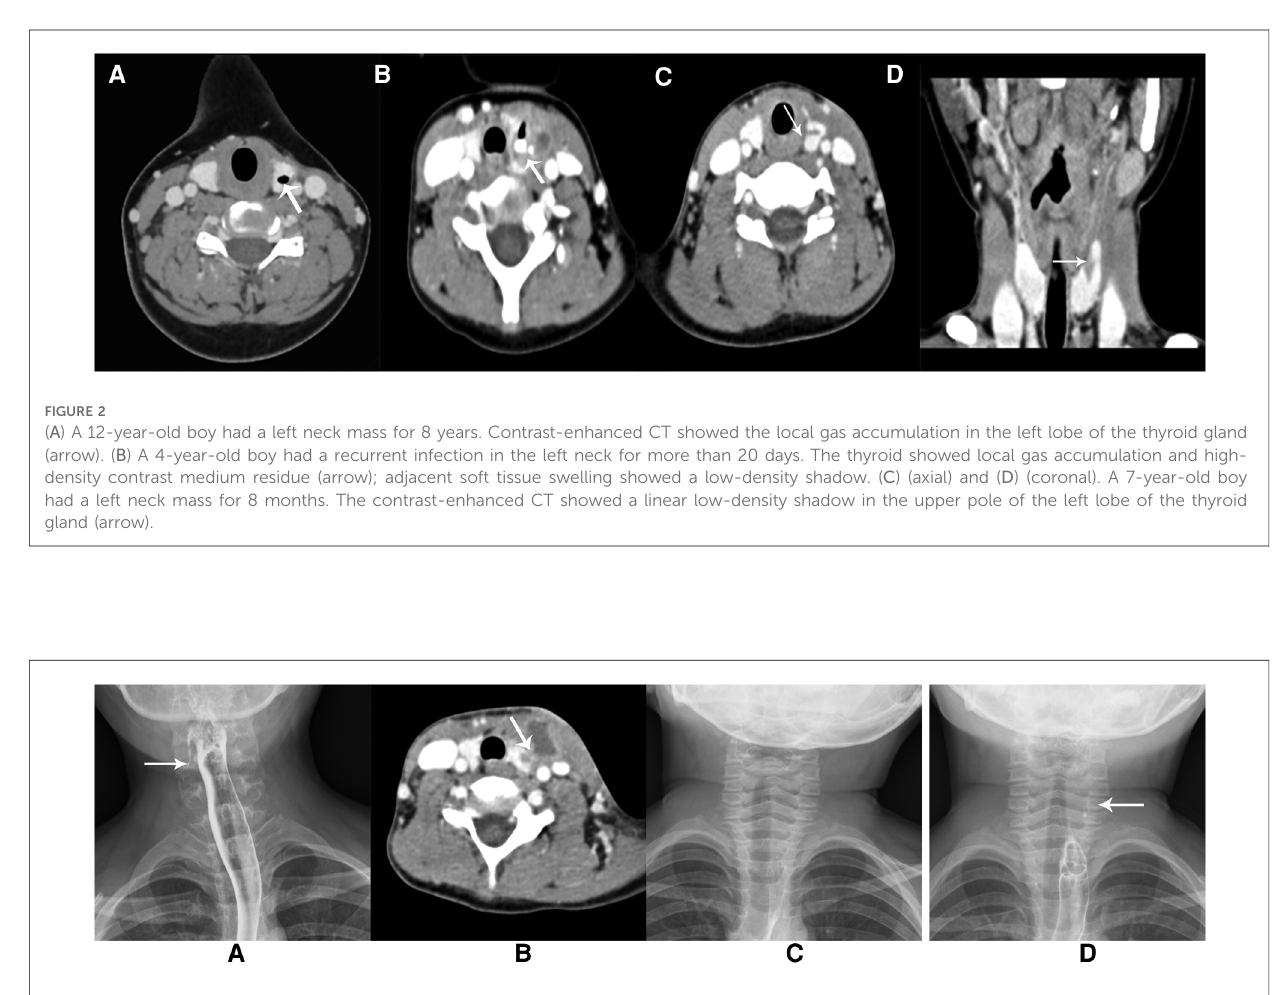
FIGURE 3 ( A ) A 10-year-old girl had a recurrent infection in the right neck for 8 years. The barium esophagography showed the strip high-density shadow on the right side, indicating pyriform fossa fi stula. ( B – D ) A boy aged 4 years and 10 months old had a recurrent mass in the left neck for 3 years. ( B ) contrast- enhanced CT showed the formation of an abscess in front of the left neck and involvement of the left lobe of the thyroid. ( C ) The barium esophagography showed normality 3 days after infection. ( D ) The esophagography showed punctate contrast agent residue in the left neck one month later, suggesting pyriform fossa fi